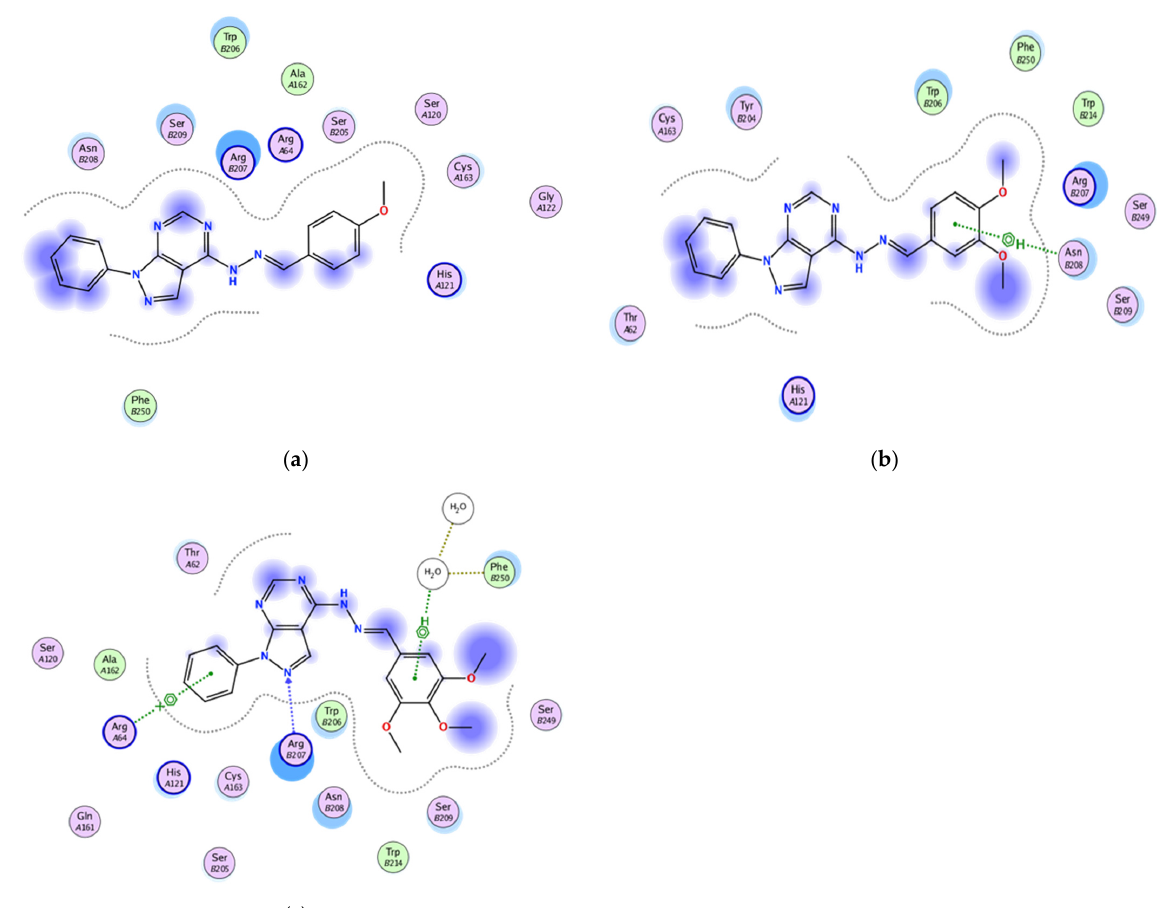
Figure 4. Two-dimensional binding mode of the test compounds ( a ) 6 , ( b ) 5 , and ( c ) 7 in the binding site of caspase-3 protein (PDB ID: 6bdv) using MOE software.